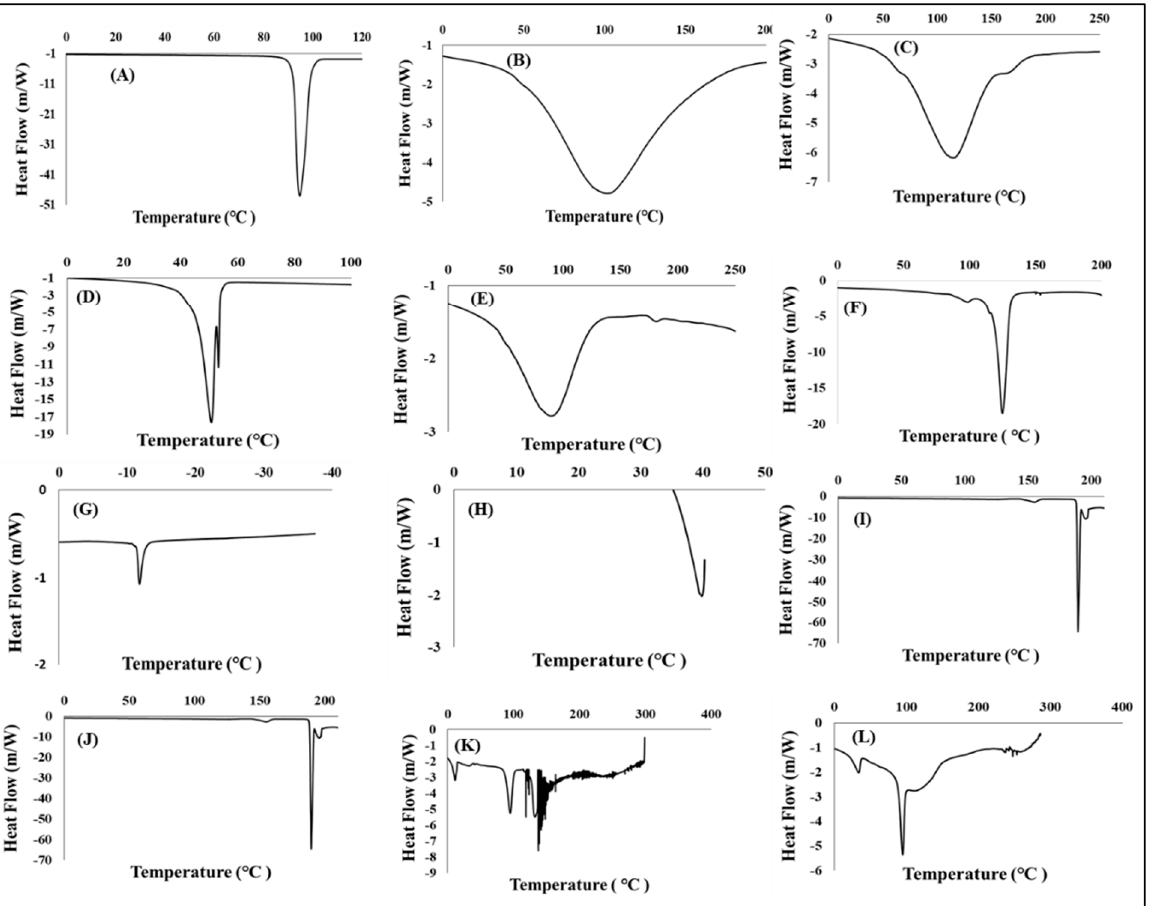
Figure 2. DSC thermographs of: ( A ) xylitol, ( B ) Primellose ® , ( C ) polyvinylpyrrolidone, ( D ) methyl- cellulose, ( E ) Kolliphor ® , ( F ) magnesium stearate, ( G ) potassium chloride, ( H ) sodium chloride, ( I ) pyrazinamide, ( J ) rifampicin, ( K ) placebo and ( L ) the drug-loaded formulation.